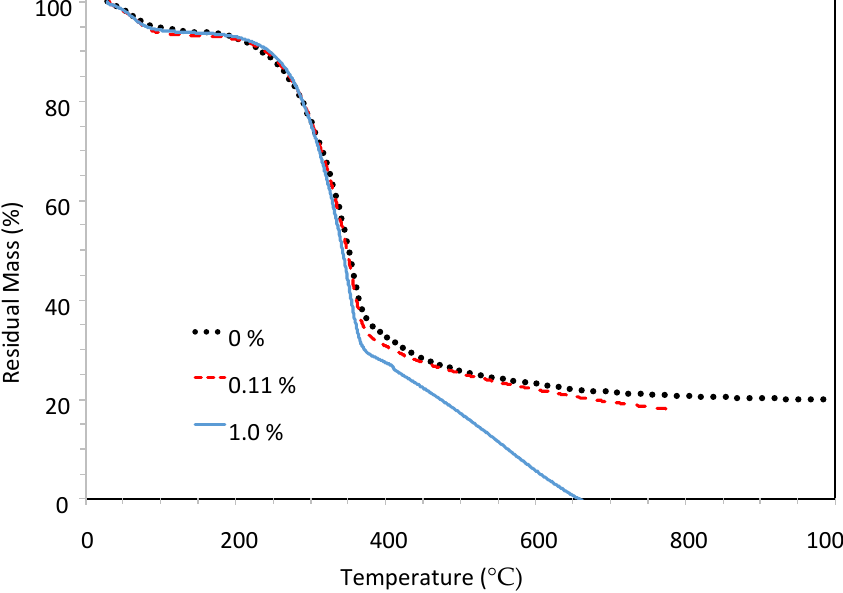
Figure 5. TGA of piñon samples pyrolyzed under nitrogen (“0%” oxygen), 0.11% (vol.) oxygen in nitrogen, or 1% (vol.) oxygen in nitrogen. The heating rate was 10 °C min −1 .